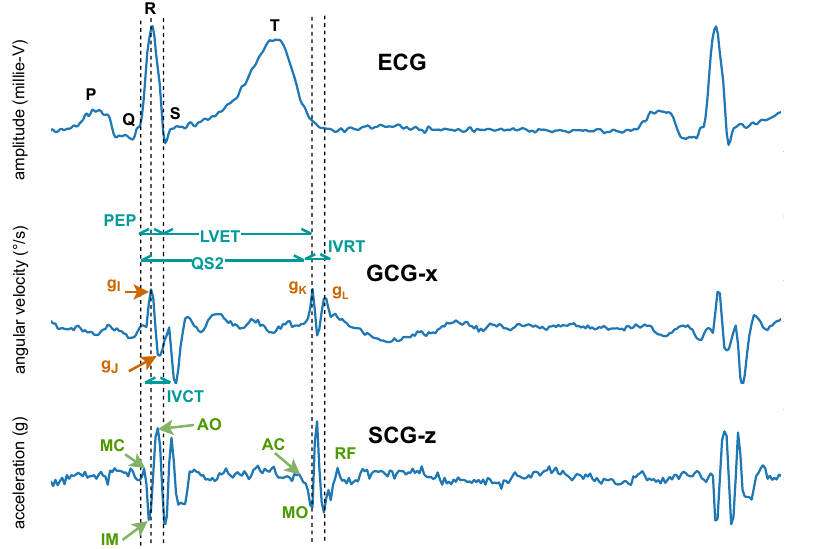
Figure 8. Characteristic seismocardiogram (SCG) and gyrocardiogram (GCG) measurements from the sternum, co-currently collected and annotated according to the ECG. Inside the SCG waveform, the identified systolic events include mitral valve closure (MC), isovolumic movement (IM), aortic valve opening (AO), rapid systolic ejection (RE), and aortic valve closure (AC). Identified diastolic events include mitral valve opening (MO) and early rapid filling (RF). Inside the GCG waveform, the g I , g J , g K , and g L points of the waveform along the x-axis of the GCG are annotated and used to estimate cardiac time intervals, including isovolumetric contraction time (IVCT), isovolumetric relaxation time (IVRT), the total electromechanical systole (QS2), the left ventricular ejection time (LVET), and the pre-ejection period (PEP)